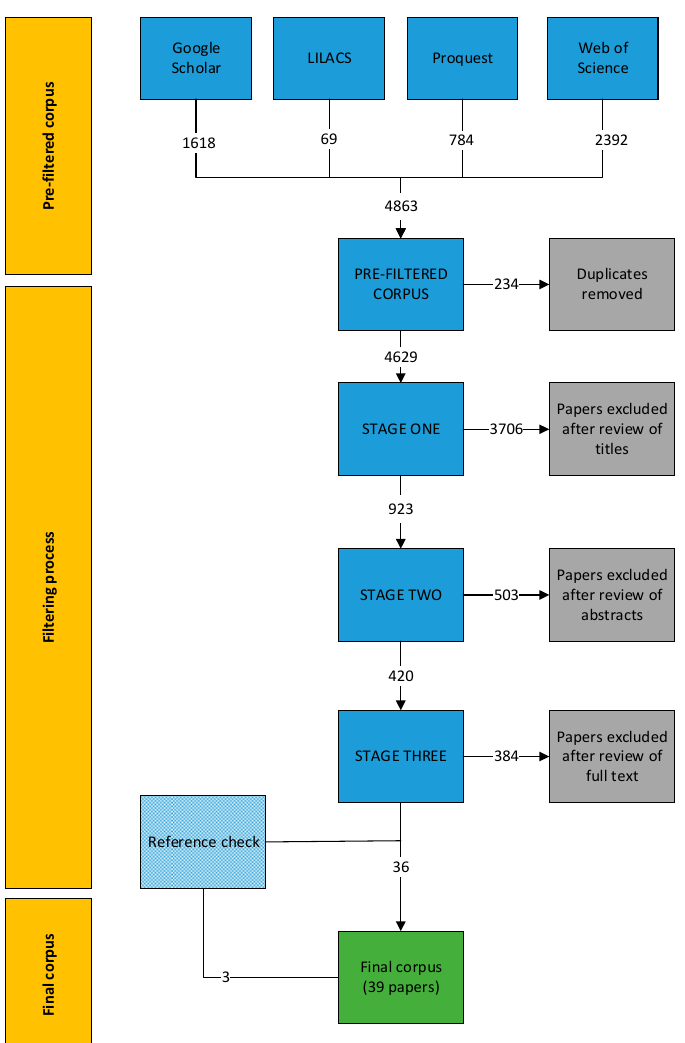
Figure 1. Number of papers included and excluded at each stage of the systematic review process. Grey boxes indicate the number excluded at each stage and the green box indicates the number of papers included in the final corpus.